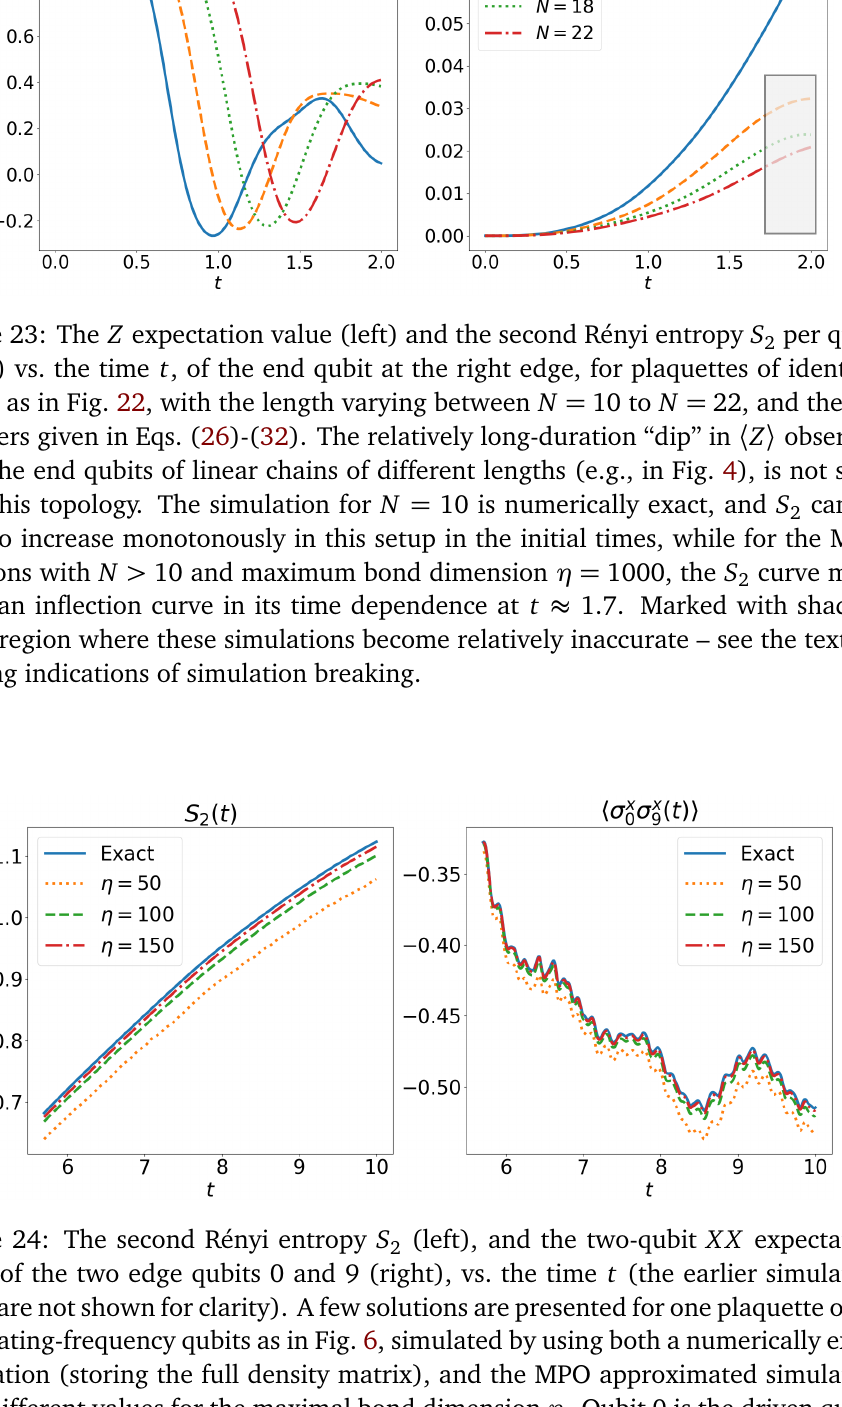
Figure 24: The second Rényi entropy S (left), and the two-qubit X X expectation 2 value of the two edge qubits 0 and 9 (right), vs. the time t (the earlier simulation times are not shown for clarity). A few solutions are presented for one plaquette of 10 alternating-frequency qubits as in Fig. 6, simulated by using both a numerically exact simulation (storing the full density matrix), and the MPO approximated simulation with different values for the maximal bond dimension η . Qubit 0 is the driven qubit, and the parameters are those of Eq. (33). From these simulations and similar ones (not shown) we conclude that η = 100 is sufficient for errors of order 1% in all studied quantities, and no qualitative problems in the